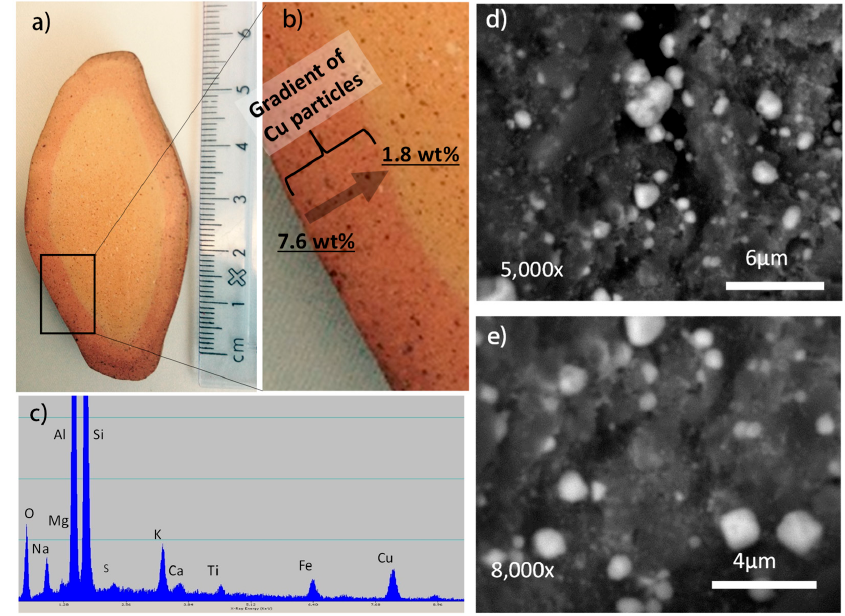
Figure 2. ( a , b ) optical microscopy images of a cross section of antimicrobial ceramic showing a zone of ceramic saturated with copper sub-microparticles; ( c ) X-ray energy dispersive spectrum for a ceramic zone saturated with copper sub-microparticles; ( d , e ) backscattered electron images of internal structure of ceramic decorated with copper sub-microparticles.